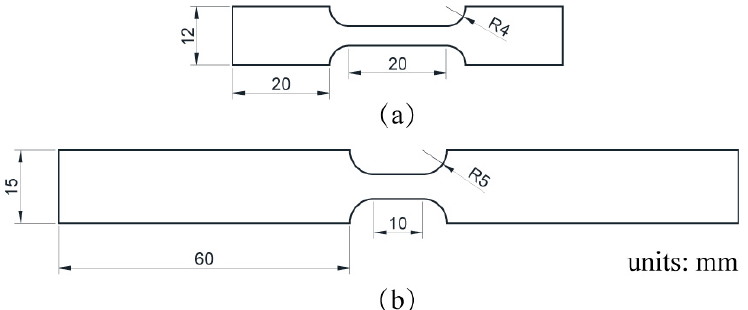
Figure 1. ( a ) Shape and dimensions of the dog-bone-shaped tensile specimens for quasi-static tests. ( b ) Shape and dimensions of the dog-bone-shaped tensile specimens for tensile tests at intermediate strain rate.